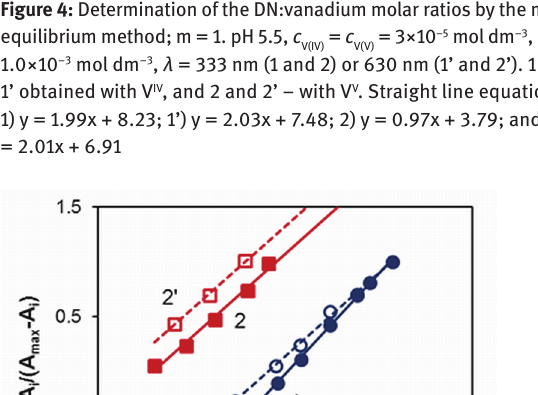
= c = 3×10 −5 mol dm −3 , c V(IV) V(V)